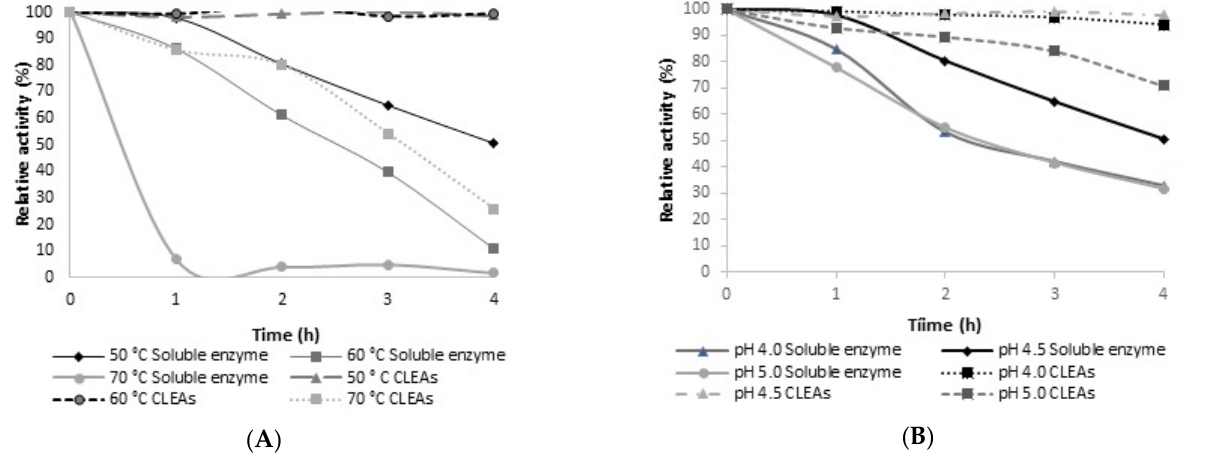
Figure 5. Hydrolytic activity profiles of soluble and immobilized β -glucosidase as a function of temperature ( A ) and pH ( B ) stability.